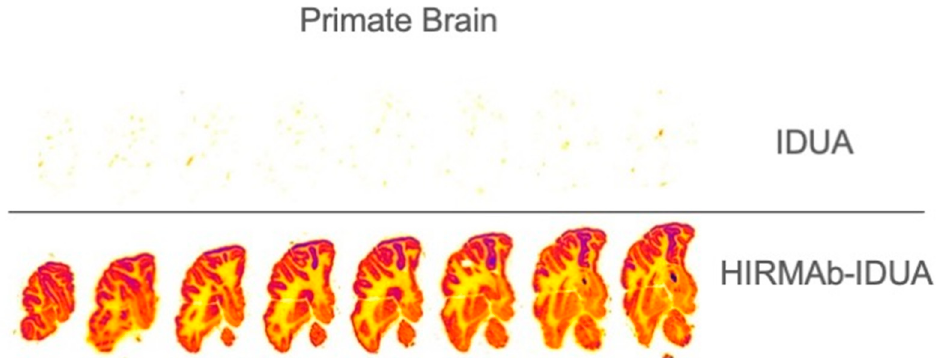
Figure 3. Autoradiography through eight parallel sagittal sections of the cerebral hemisphere of the rhesus monkey obtained 2 h after the IV administration of either the [ 125 I]-HIRMAb-IDUA fusion protein ( bottom ) or [ 125 I]-IDUA ( top ). The section on the left-hand side is the most lateral part of brain, and the section on the right-hand side is the most medial part of brain. The cerebellum is visible in the more medial sections of the brain. The BBB-penetrating HIRMAb-IDUA gained access to the brain, producing a global distribution throughout this organ. On the contrary, IDUA does not cross the BBB, showing just background activity in the primate brain. From [62] with permission.